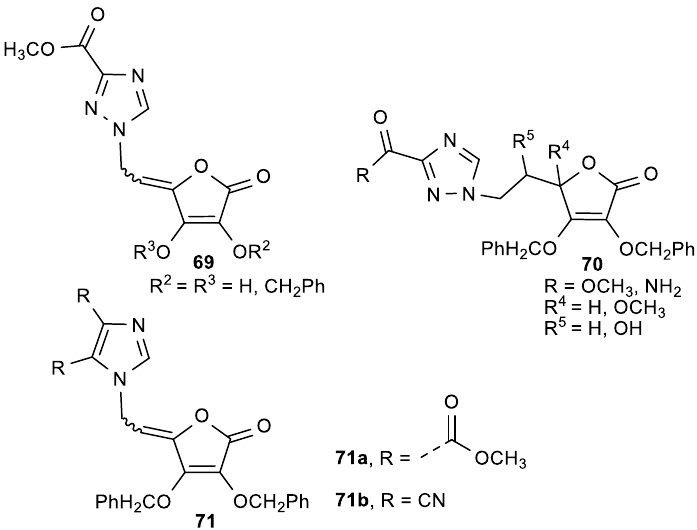
Figure 26. The 1,2,4-triazole ( 69 , 70 ) and 4,5-disubstituted-imidazole ( 71 ) ASA derivatives. Table 27. The antitumor and anti- hepatitis C virus (HCV) activities of the 4,5-disubstituted-imidazole ASA derivatives.